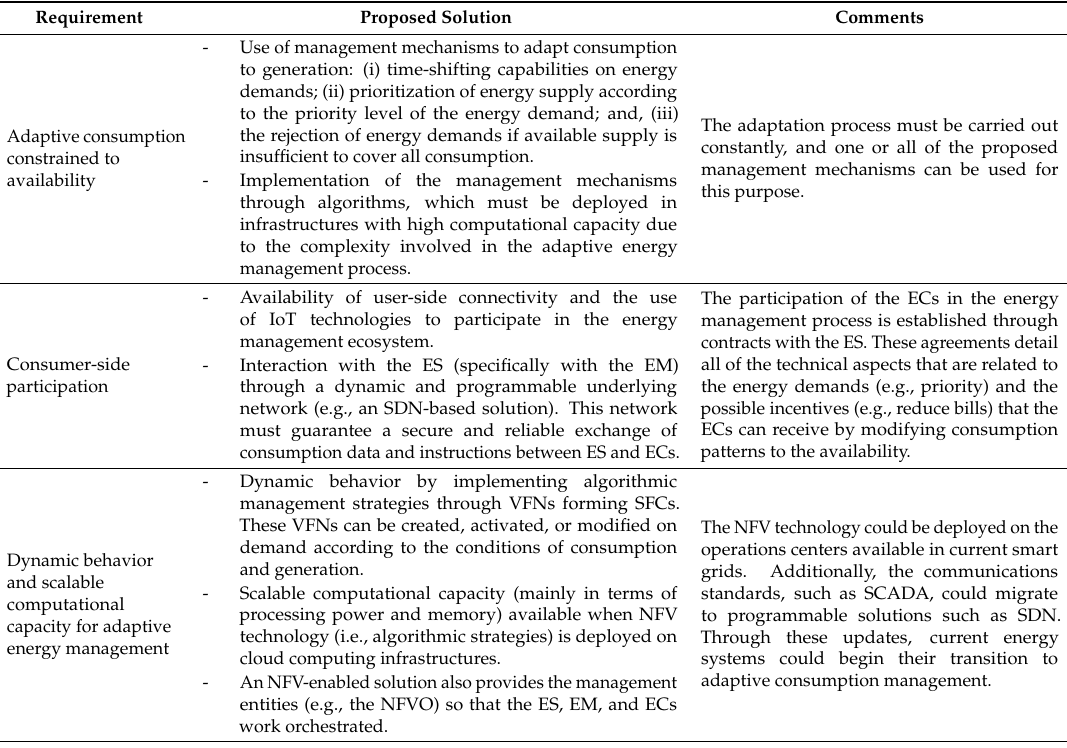
Table 11. Summary of requirements and proposed solution for adaptive energy management in an Internet of Things (IoT) and NFV enabled